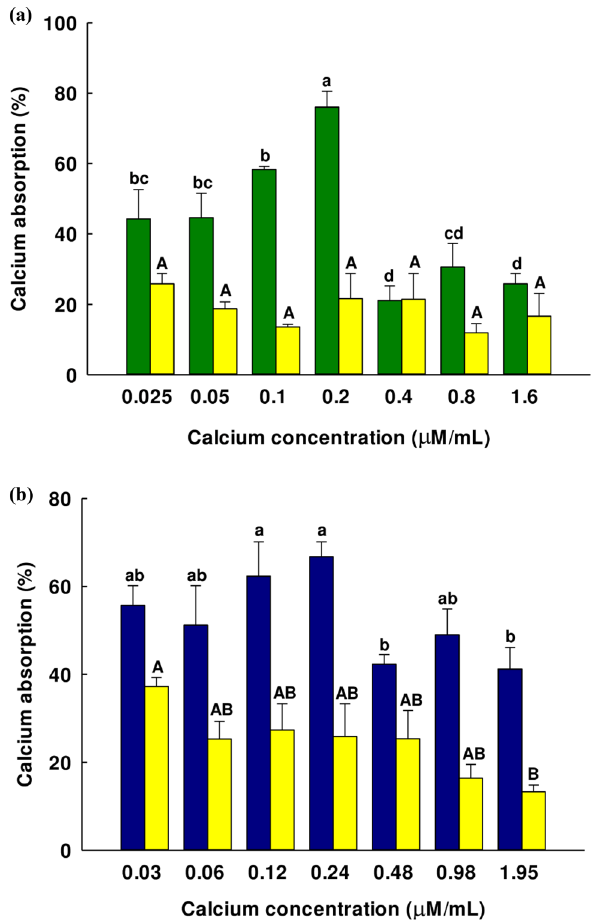
Figure 6. ( a ) Effects of Basil-1-calcium complex ( ), CaCl 2 ( ) solution and ( b ) Basil-2-calcium complex ( ) on the uptake of calcium in Caco-2 cell monolayers at different CaCl 2 concentrations. The values are shown as percentage of calcium-binding activity ± SD, while all testing was carried out in triplicate. Where the mean is shown with a different letter, this indicates a significant difference in Duncan’s multiple range test ( p <